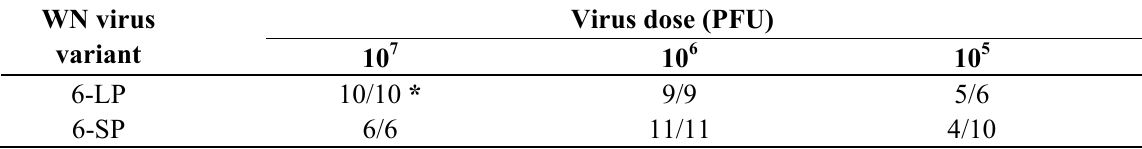
Table 1. Disseminated infection rates of Culex pipiens during peroral infection experiments with WN